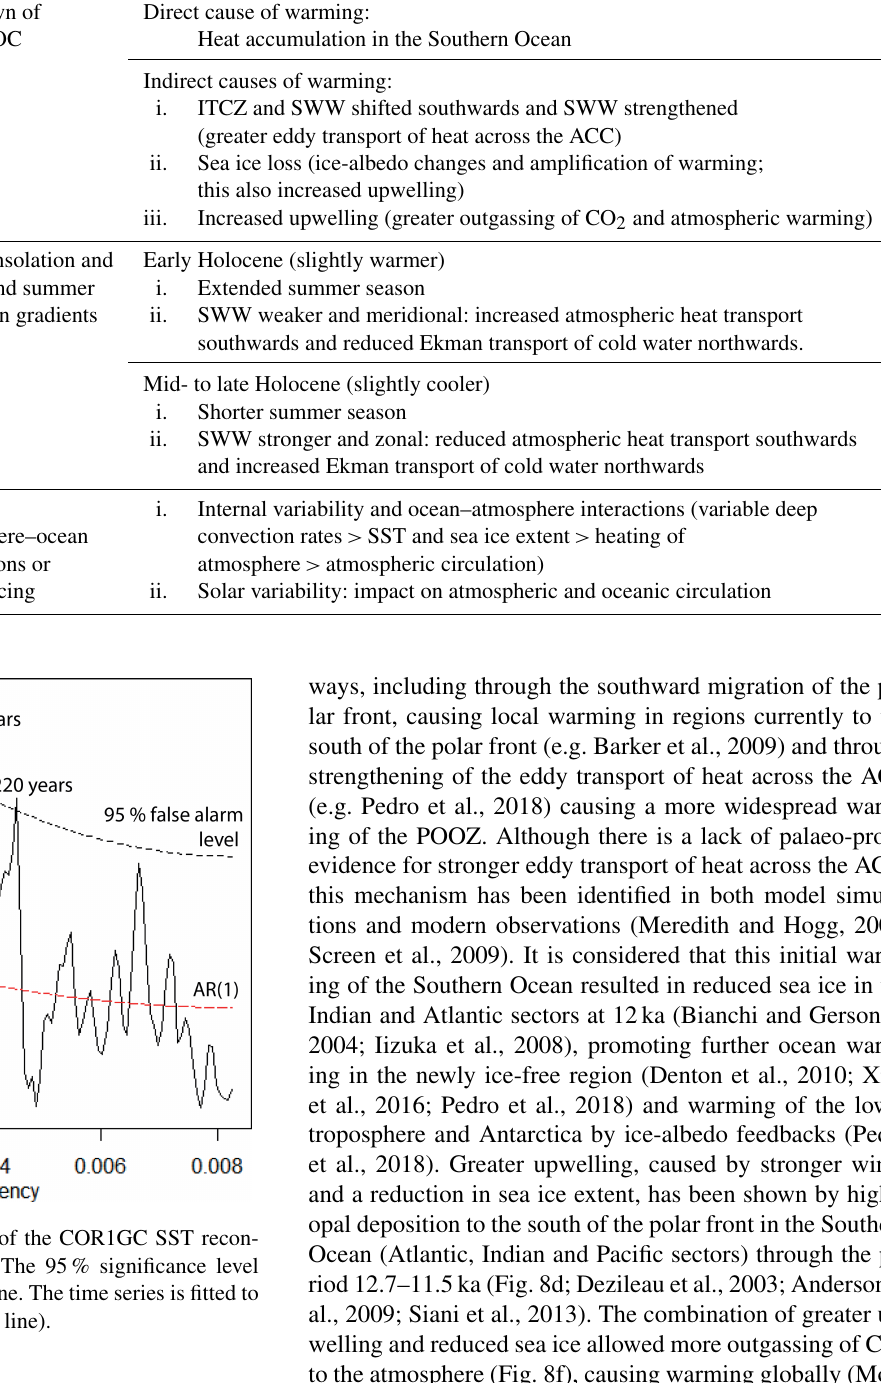
from 14 to 11 ka but only shifted southward to a more pole- ward position at 12.5 ka (Fig. 8c; Fletcher and Moreno, 2011; Saunders et al.,